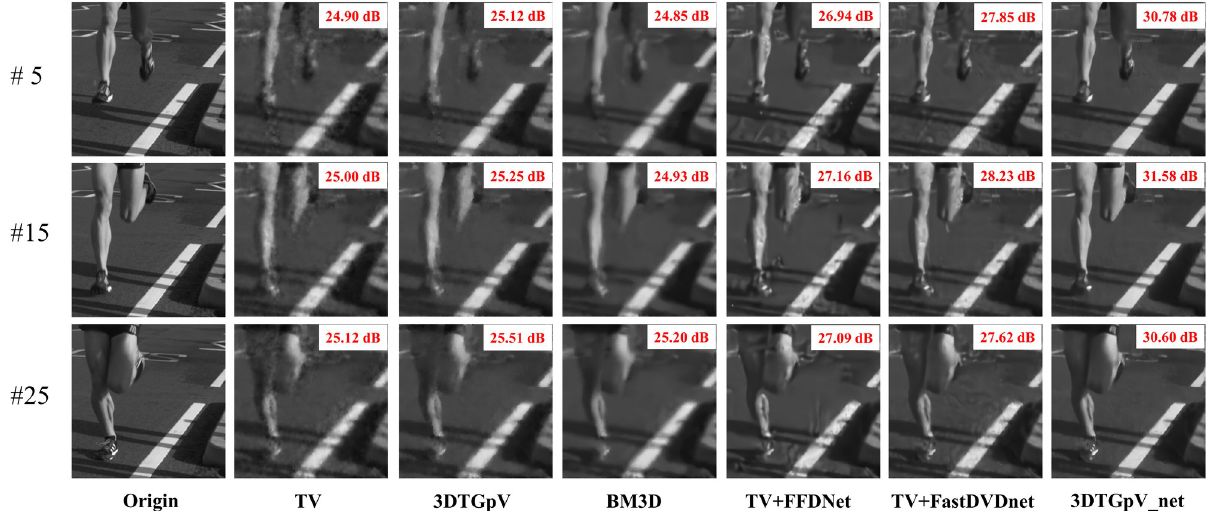
Fig 5. The 5 th , 15 th and 25 th reconstructed frames based on simulated datasets: Runner.